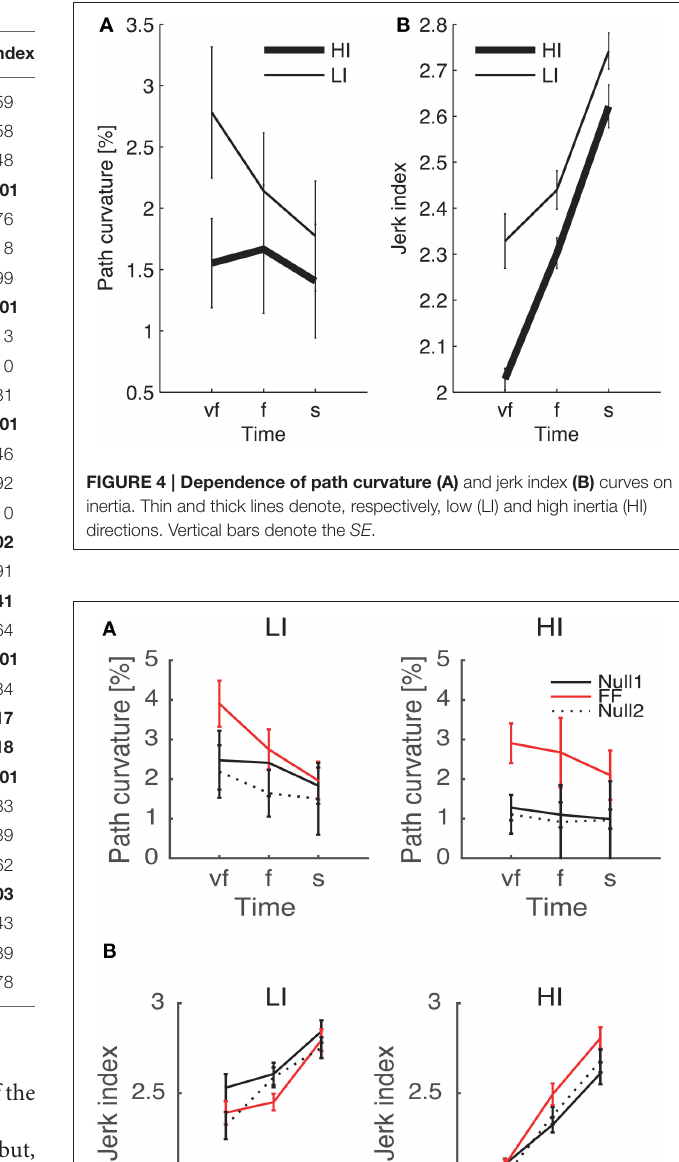
TABLE 1 | ANOVA table for path curvature and the jerk index.